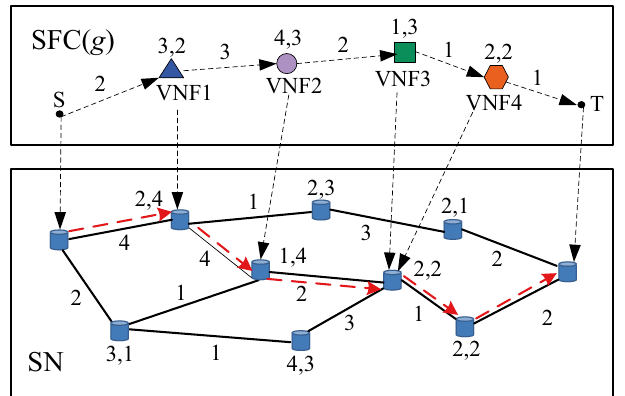
Figure 3. The SFC( g )